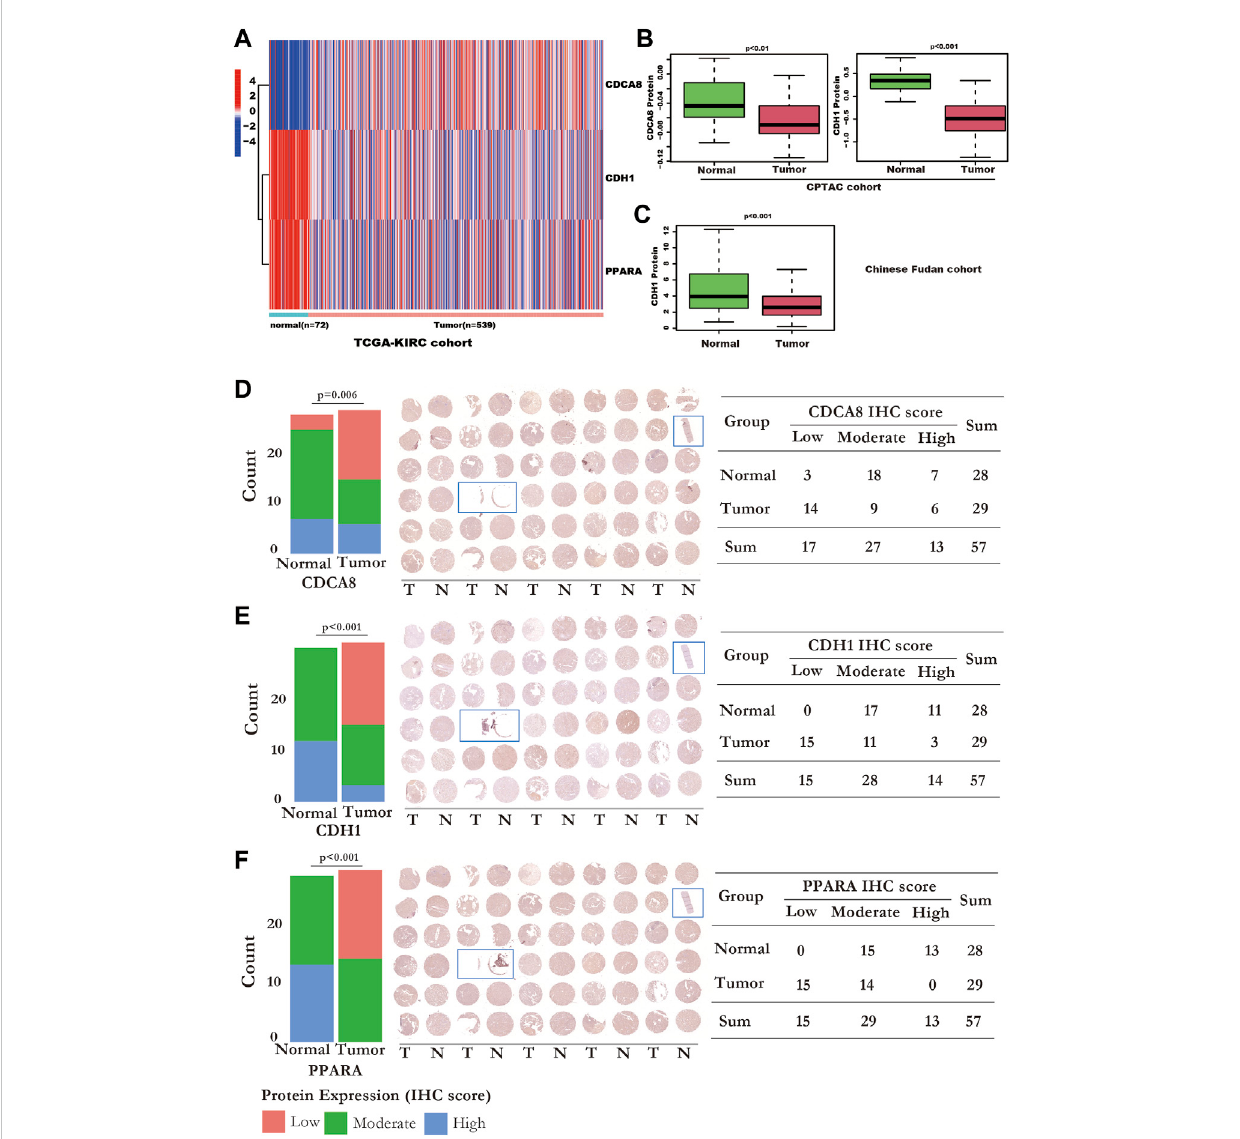
FIGURE 8 The RNA and protein expression of the SUMOylation risk model genes. (A) The RNA expression values of cell division cycle-related protein 8 (CDCA8) ( p < 0.001), CDH1 ( p < 0.001), and peroxisome proliferator-activated receptor alpha (PPARA) genes ( p < 0.001), between normal and kidney cancer tissues from the TCGA-KIRC dataset. (B) CDCA8 and CDH1 protein expression of the normal and tumor tissues in the National Cancer Institute ’ s Clinical Proteomic Tumor Analysis Consortium cohort dataset. (C) CDH1 protein expression status in Chinese Fudan cohort. (D) The IHC detection of CDCA8 protein expression in TMA tissues. Left panel: the bar plot shows the CDCA8 expression status detected by IHC. Middle panel: The whole TMA slide of CDCA8 detection; the tissue with the blue rectangle means these tissues were excluded from statistics because the tissue was too little. Right panel: displayed detailed CDCA8 statistic data. (E) The IHC detection of CDH1 protein expression in TMA tissues. Left panel: the bar plot shows the CDH1 expression status detected by IHC. Middle panel: The whole TMA slide of CDH1 detection; the tissue with the blue rectangle means these tissues wereexcludedfromstatisticsbecausethetissuewastoolittle.Rightpanel:displayeddetailedCDH1statisticdata. (F) TheIHCdetection ofPPARAprotein expression in TMA tissues. Left panel: the bar plot shows the PPARA expression status detected by IHC. Middle panel: The whole TMA slide of PPARA detection; the tissue with the blue rectangle means these tissues were excluded from statistics because the tissue was too little. Right panel: displayed detailed PPARA statistic